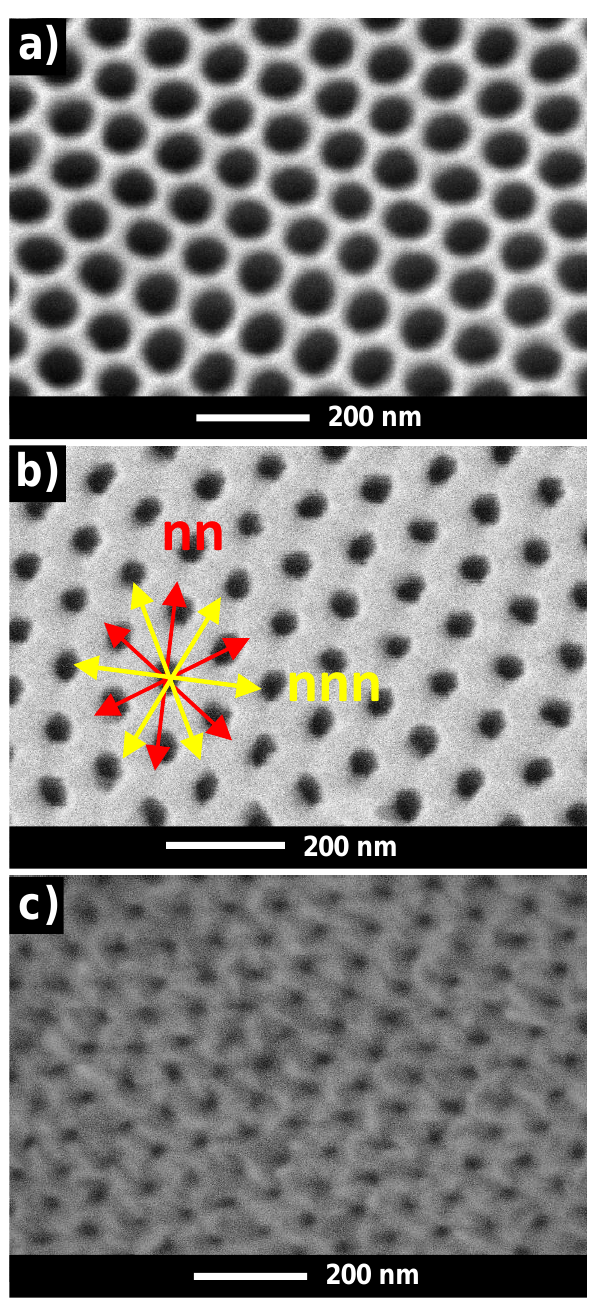
Figure 1. ( a ) Top-view surface Scanning Electron Microscope (SEM) image of a nanoporous alumina membrane employed as patterned substrate for depositing the antidots arrays showing the hexagonal ordering of the nanopores, (interpore distance Dint = 105 nm, pore diameter dp = 75 nm); ( b ) SEM top-view image of the surface of 30 nm thick Dy 13 Fe 87 thin film antidot array, obtained by replicating the alumina template shown in ( a ). The in-plane easy anisotropy axis, nn , and in-plane hard anisotropy direction, nnn , are indicated by red and yellow arrows, respectively; ( c ) SEM top-view of the antidot array Dy 13 Fe 87 sample with 50 nm in thickness.